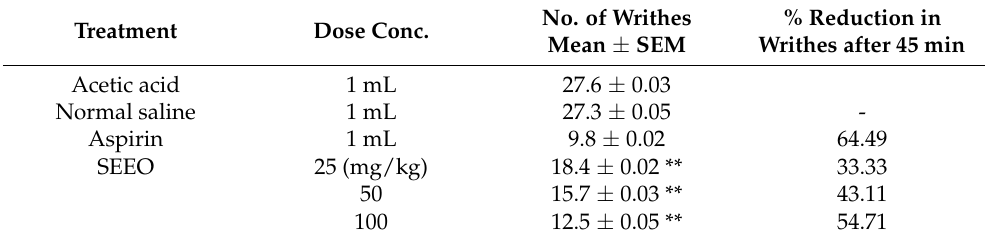
Table 2. Analgesic significance of essential oils of S. edelbergii .